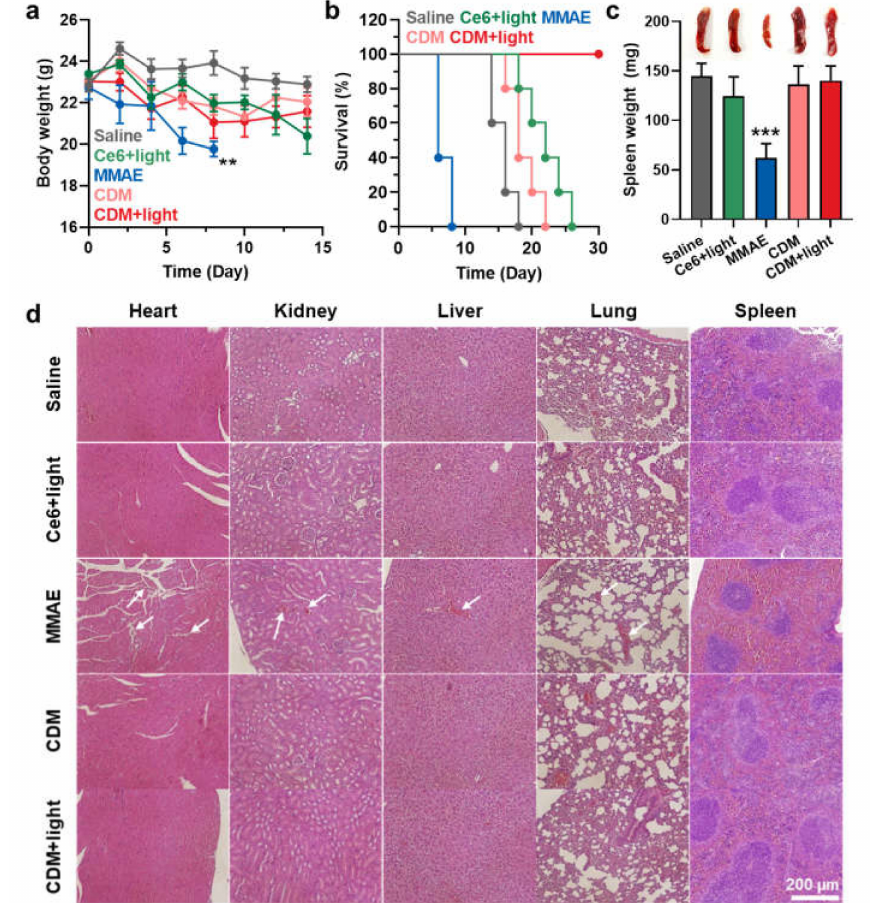
Figure 5. The safety of CDM treatment in orthotopic pancreatic cancer models. ( a ) The body weight change during treatment with saline, MMAE, Ce6, or CDM. ( b ) Mice survival during treatment with saline, MMAE, Ce6, or CDM. ( c ) The spleen weights of orthotopic pancreatic cancer models after 8 days of each treatment. ( d ) The organ tissues stained with H&E after 8 days of each treatment. The asterisks in Figure indicate the comparison to the CDM+light